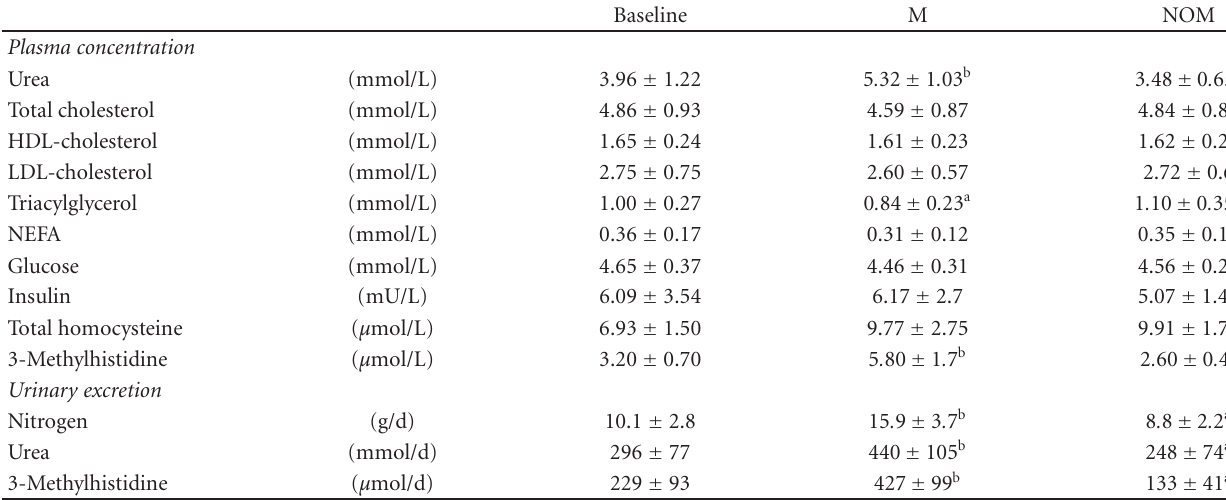
Table 3: Plasma metabolite concentrations, urinary excretion of nitrogen, urea, and 3-methylhistidine of women at baseline and after 4 weeks periods of either additional meat consumption (M, 200g pork fillet/d) or exclusion of meat products (NOM).